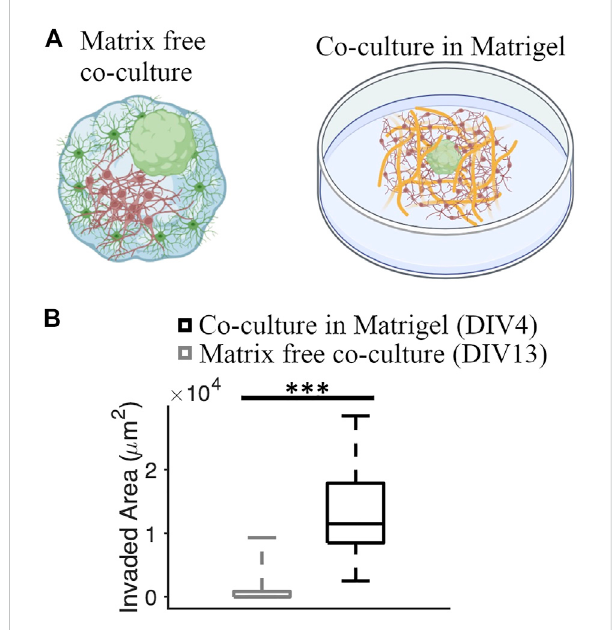
FIGURE 7 Comparison of GBM invasion between different co-culture systems. (A) Schematics of a matrix-free cortical-GBM spheroid co- culture and co-culture of GBM spheroid with cortical cells embedded in Matrigel matrix. (B) Quanti fi cation of the invaded area in differenttypesof cultures. N = 74 and 12 GBM spheroids in co-culture with and without Matrigel matrix, respectively. KS test was used to measure statistical signi fi cance. *** p < 10 – 7